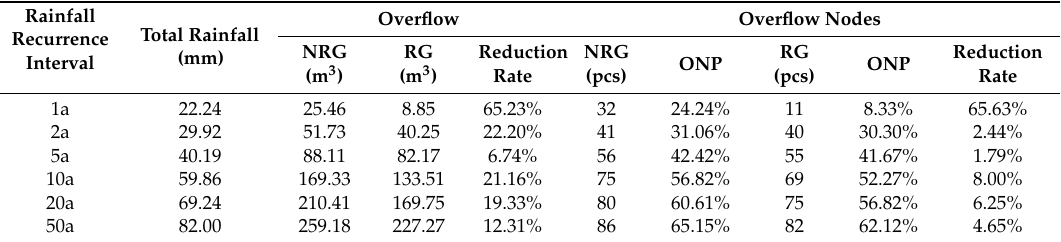
Table 2. Statistical table of overflow nodes.